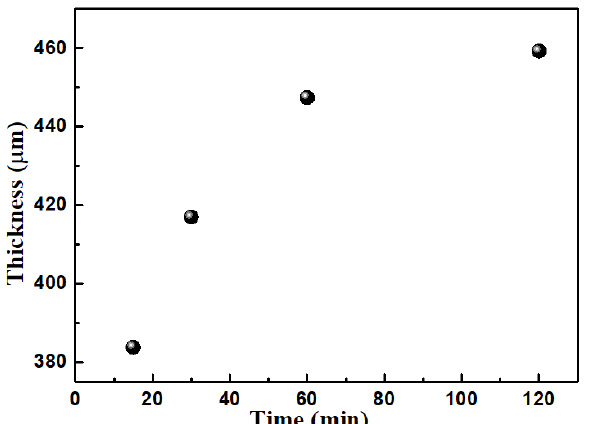
Figure 8. Time dependence of the thickness of the chromized samples deposited at 1000 °C for different deposition times.